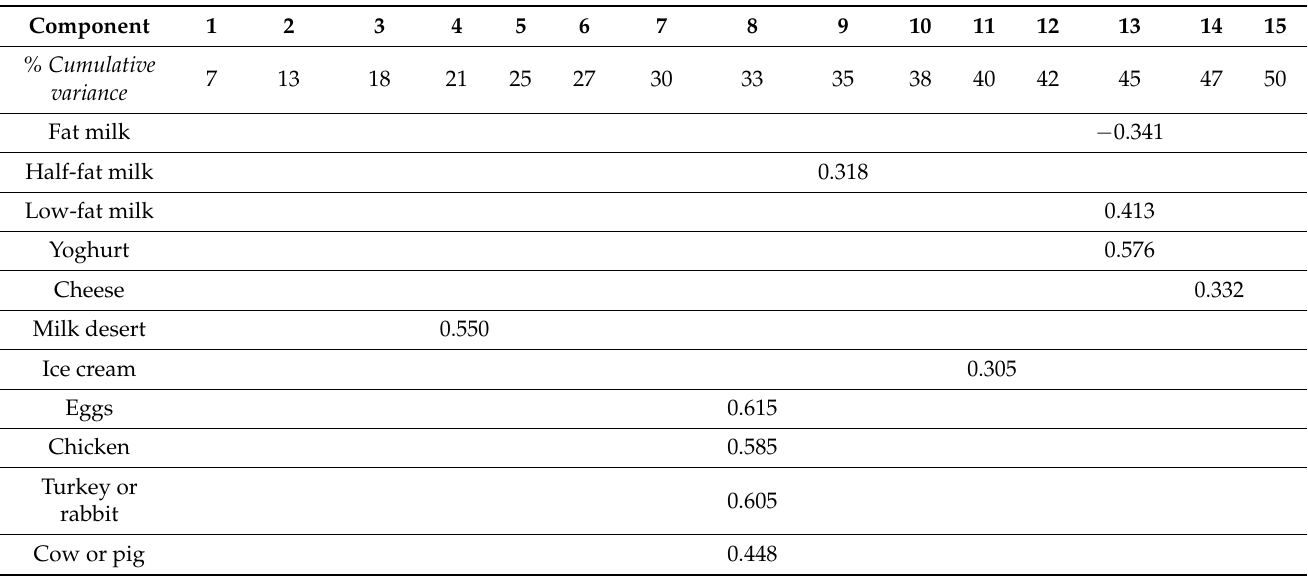
Table 4. Component loadings of food patterns obtained by principal component analysis with Varimax rotation.